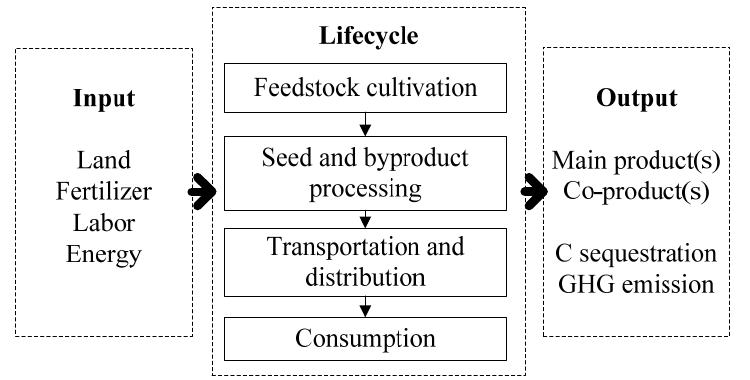
Figure 1. The lifecycle production system of Jatropha